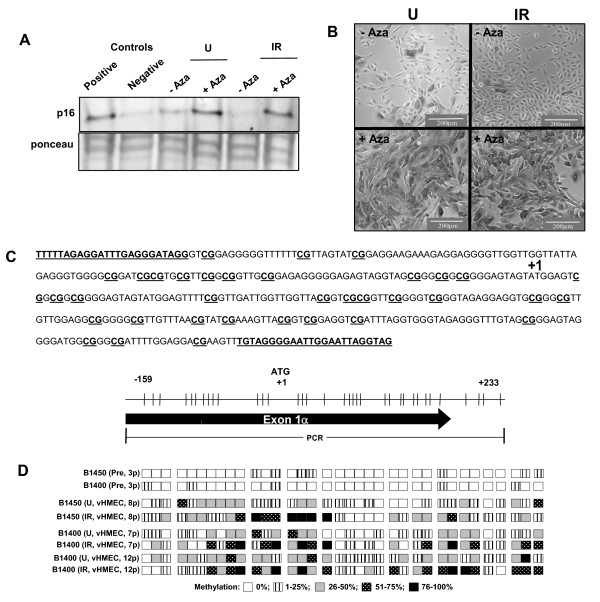
The p16 gene is silenced epigenetically in both unirradiated and irradiated human mammary epithelial cells. (A) Immunoblot analysis shows that p16 protein expression is very low in the eighth passage (8p) variant human mammary epithelial cells (vHMEC) cultures derived from both unirradiated and irradiated cells, but that it is readily induced to similar extents in both cultures treated with 5-aza-deoxycytidine (Aza). Lysates of HMEC undergoing stasis and MCF-7 cells were used as positive and negative controls, respectively. (B) p16 immunohistochemistry indicates that 8p vHMEC cultures derived from both unirradiated and irradiated cells contain primarily p16(-) cells, and that p16 protein can be induced in virtually all cells in both cultures by 72 hr treatment with 3.3 μM 5-aza-deoxycytidine. (C) DNA sequence of the CpG island region and a map of the -159 to +233 region of the p16 gene indicate the 35 CpG sites (CG or vertical lines) analyzed for methylation status, and their positions relative to the translational start site (ATG) and exon 1α. Primers used for PCR amplification are underlined. (D) The percent methylation of specific CpG sites (indicated by degree of shading) in the -159 to +233 region of the p16 gene was determined by sequencing of individual bisulfite-treated DNAs obtained from the indicated pre-stasis HMEC and vHMEC cultures from specimens B1450 and B1400.